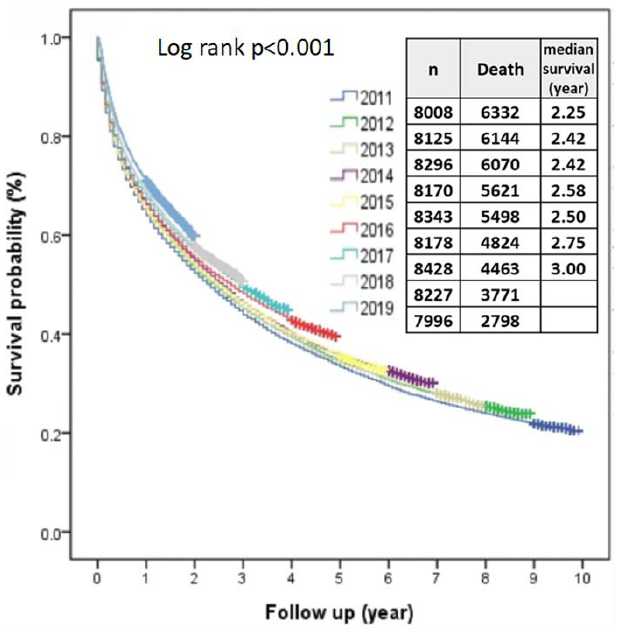
Figure 7. The overall median survival rates of HCC from 2011 to 2019 improved